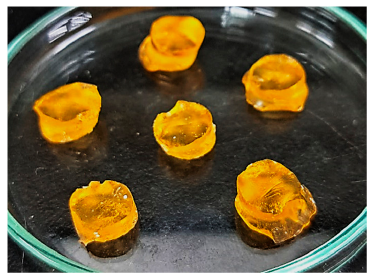
Figure 2. Physical appearance of CS/CP/PVAcPAa hydrogel.